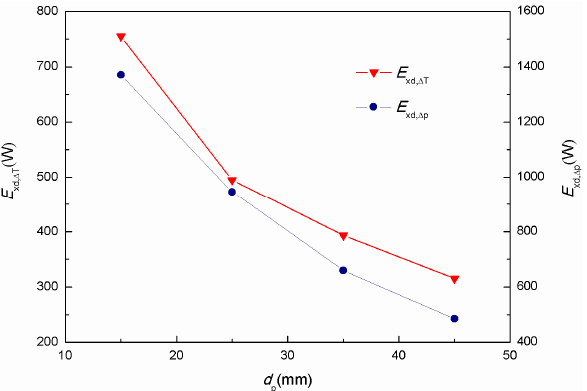
Figure 18. The distributions of the local heat transfer exergy destruction rate of sinter for different particle diameters.